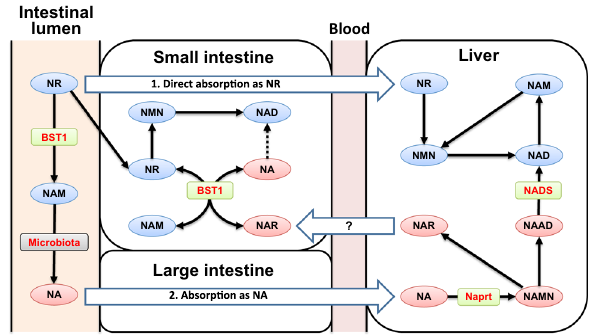
Fig. 10 Schematic diagram showing metabolic fates of orally administered NR in vivo. Part of orally administered NR is directly absorbed from the small intestine. Orally administered NR is also degraded to NAM by BST1 in the small intestine. NAM derived from NR is further metabolized to NA by gut microbiota in the large intestine. Then, NA absorbed from the large intestine is used for the generation of NAD + in the liver via the Preiss – Handler pathway. However, the base-exchange reaction for NR and NAR may function as a backup route when Preiss – Handler pathway is